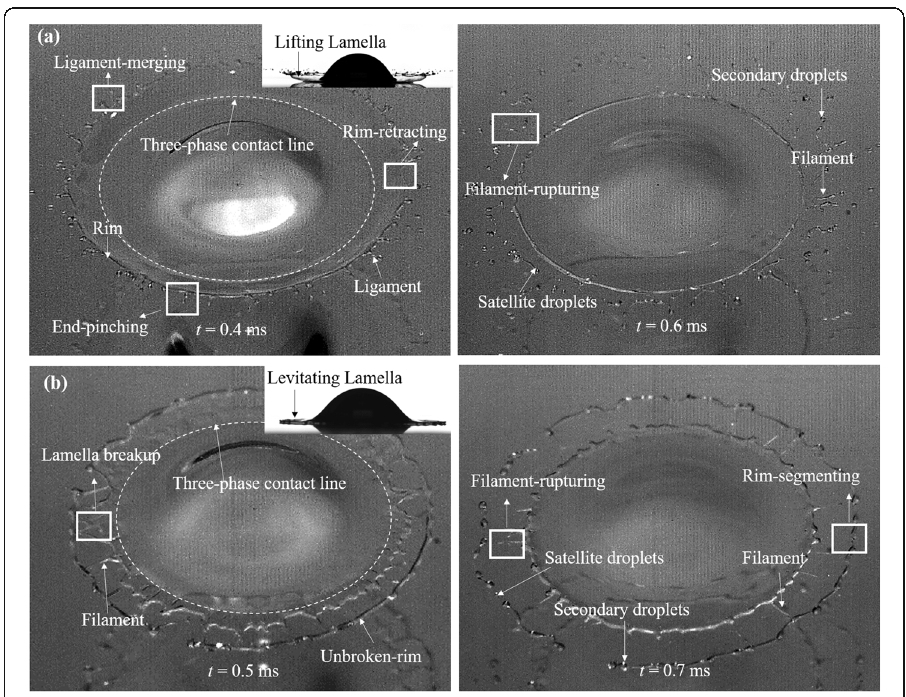
Fig. 3 Formation of secondary droplets in different splashing patterns: a Corona splashing, D 0 = 3.7 mm, U 0 = 3.4 m/s, µ = 2.93 mPa·s, Oh = 0.0057, We = 709, t = 0.4 ms & 0.6 ms; b Levitating-lamella breakup, D 0 = 3.7 mm, U 0 = 3.4 m/s, µ = 6.72 mPa·s, Oh = 0.0123, We = 808, t = 0.5 ms & 0.7